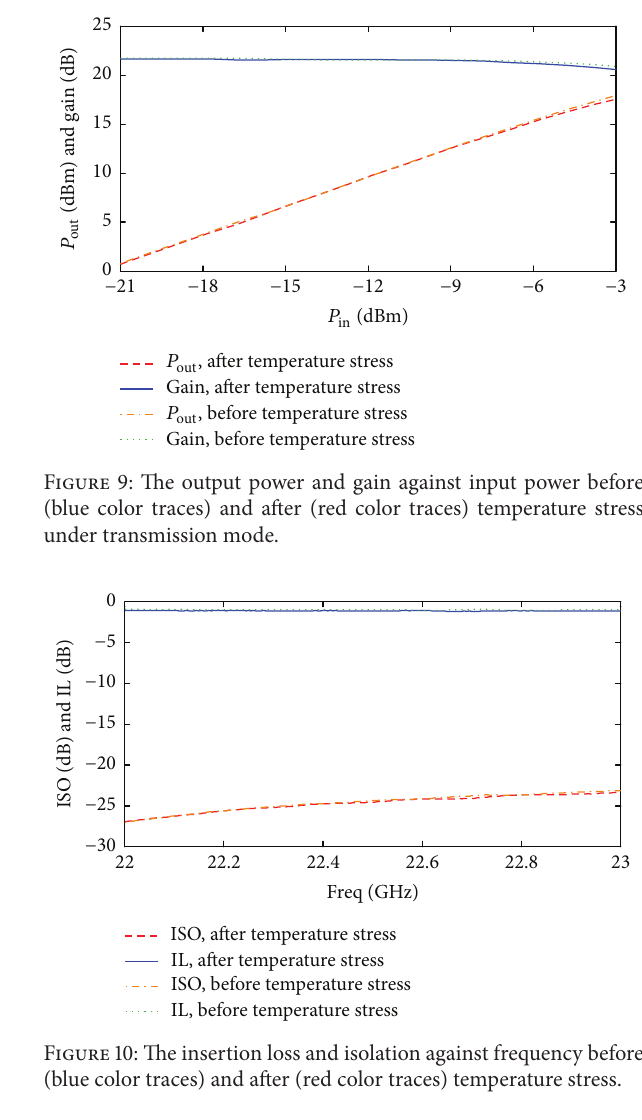
Figure 8: The mother board of the packaged DUT.